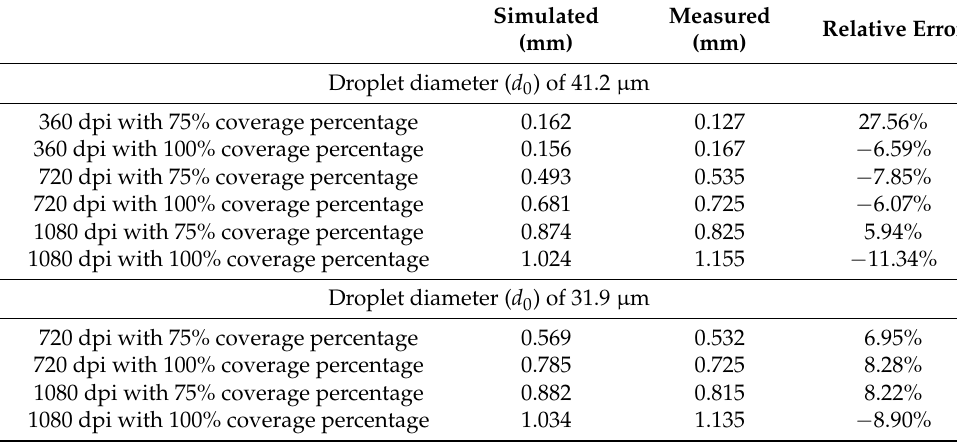
Table 1. Simulated and measured sample heights for different printing conditions.